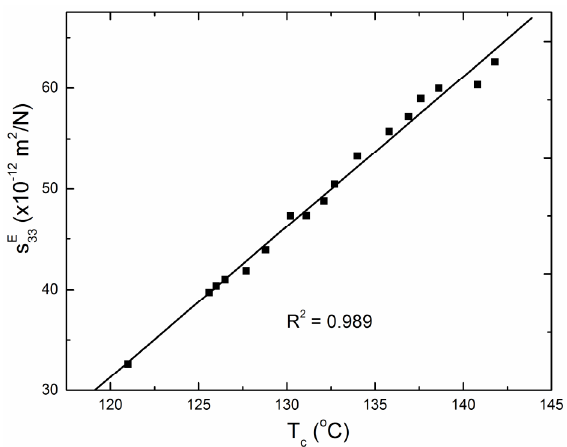
Figure 3. Compliance of crystals along growth direction.